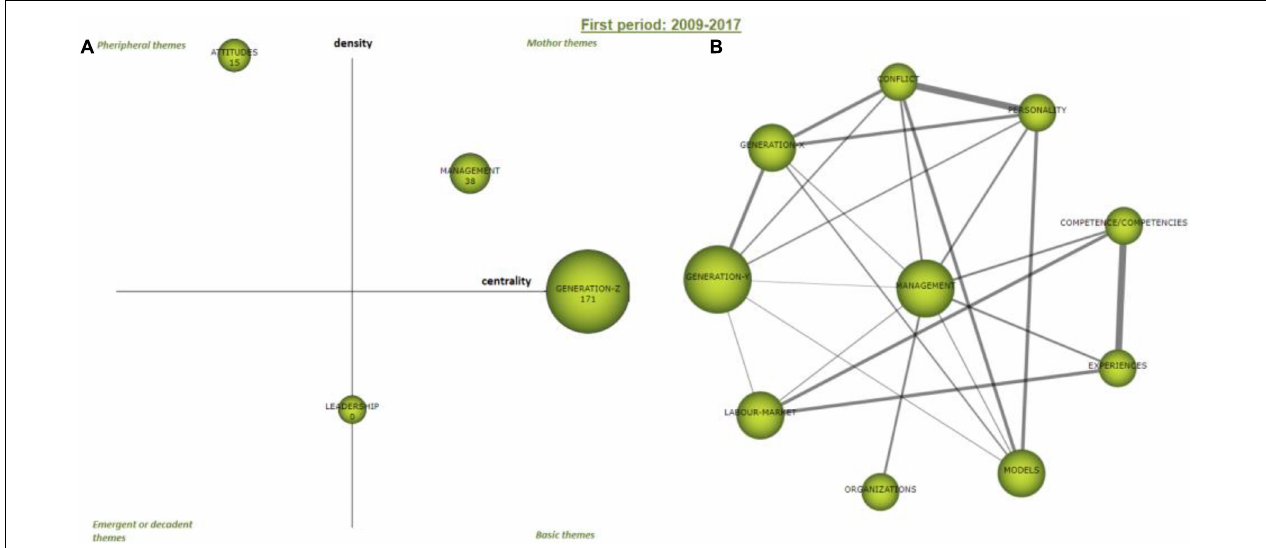
FIGURE 5 | Period 2009–2017 strategic diagram (A) and the motor cluster’s network (B) . Source: Elaborated with SciMAT.